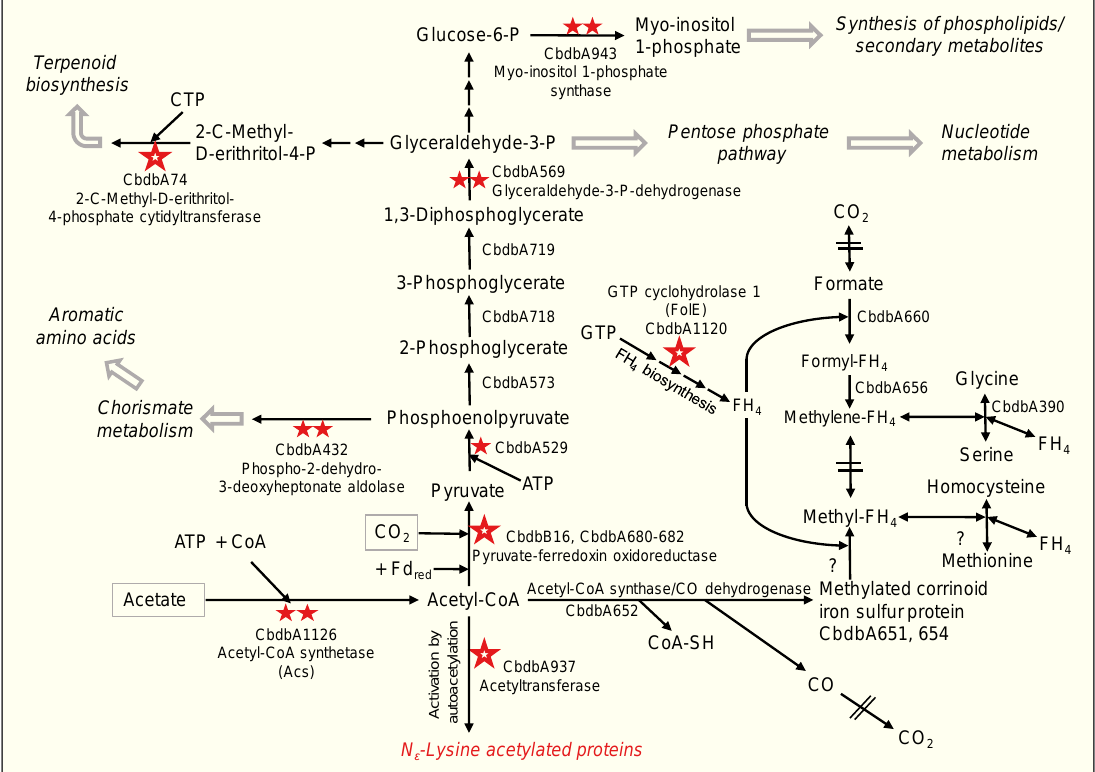
Figure 2. Carbon metabolism of Dehalococcoides mccartyi strain CBDB1 demonstrating the main routes of acetate utilization via acetyl-CoA, gluconeogenesis, and acetyl-CoA synthase/CO dehydrogenase (black arrows) and the diverging biosynthetic pathways (open arrows). Nε-lysine-acetylated proteins are indicated by red asterisks: A high acetylation abundance ratio is indicated by a large asterisk (see Table 1), while multiple acetylation sites are denoted by two smaller asterisks (Table 2) and less abundant acetylation by a single, small asterisk (Table S2). The incomplete Wood–Ljungdahl pathway displayed on the right is a source of C1 carriers, needed e.g., for the synthesis of methionine and serine, and might be strongly influenced by the availability of tetrahydrofolate (FH 4 ). The locus tags of the enzymes annotated in the genome of strain CBDB1 are displayed. The ? signifies that enzymatic activity was demonstrated; however, to date, the corresponding enzyme has not been annotated [38].